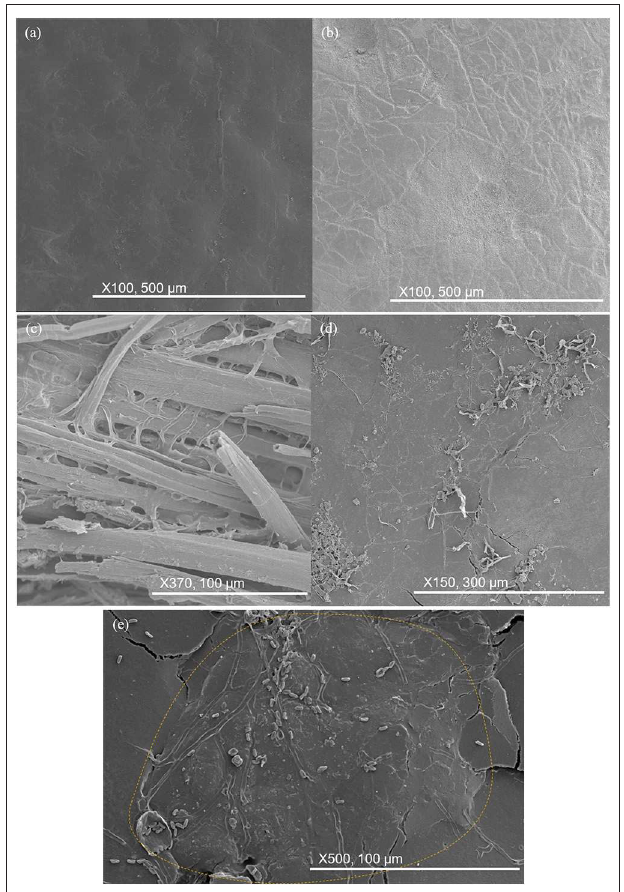
FIGURE 12 | SEM images of key changes in samples after 56 days. (a) HIPS remains unchanged; (b) craze markings on neat PHBV; (c) elementary fiber separation in composite samples; (d) filamentous structures growing on ENR particles; (e) peanut-shaped objects observed on ENR particles.